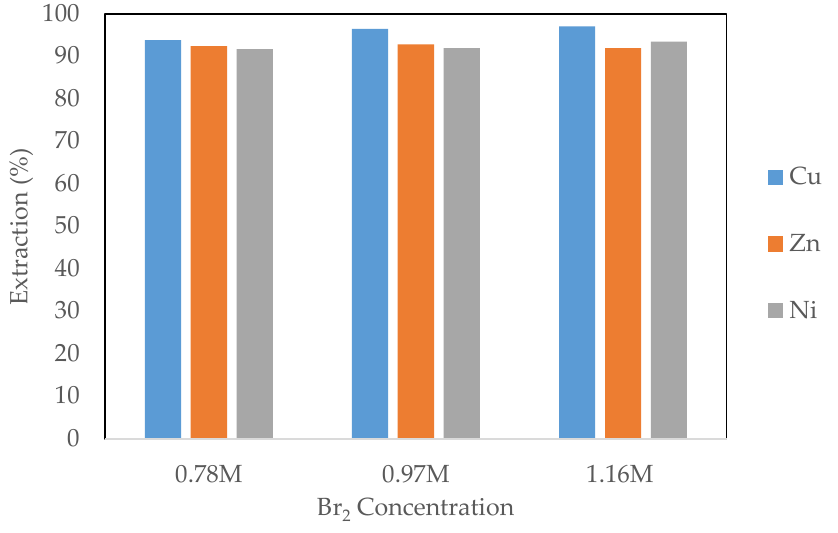
Figure 8. Dissolution of base metals (Cu, Ni and Zn) at various concentrations of bromine (23.5 °C and natural pH).